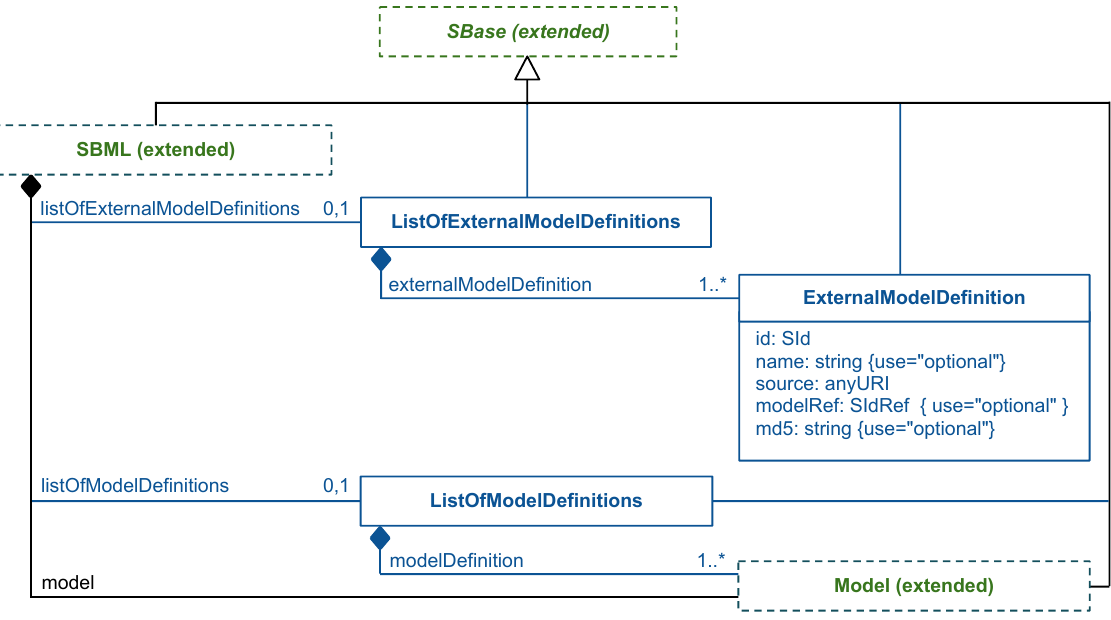
Figure 2: The definitions of the extended SBML class as well as the new classes ListOfModelDefinitions , ListOfExter- nalModelDefinitions , and ExternalModelDefinition . The extended Model class is defined in Section 3.4 on page 15. <?xml version="1.0" encoding="UTF-8"?> <sbml xmlns="http://www.sbml.org/sbml/level3/version1/core" level="3" version="1"